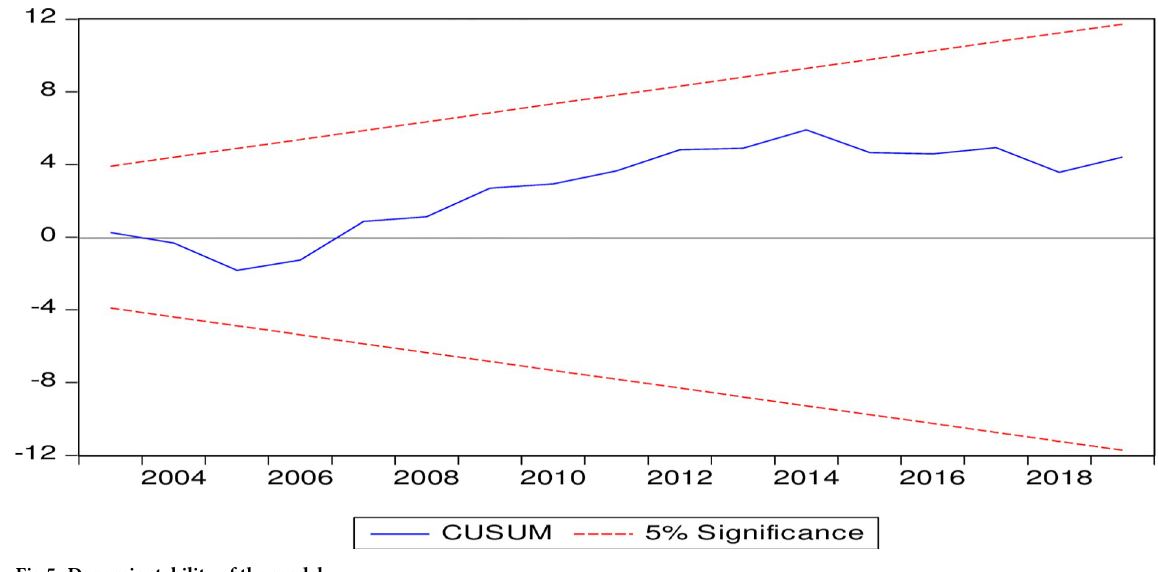
Fig 5. Dynamic stability of the